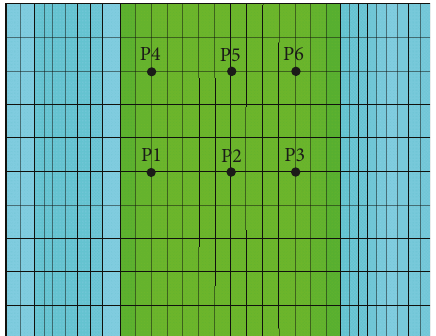
Figure 13: Key points on the embankment surface.